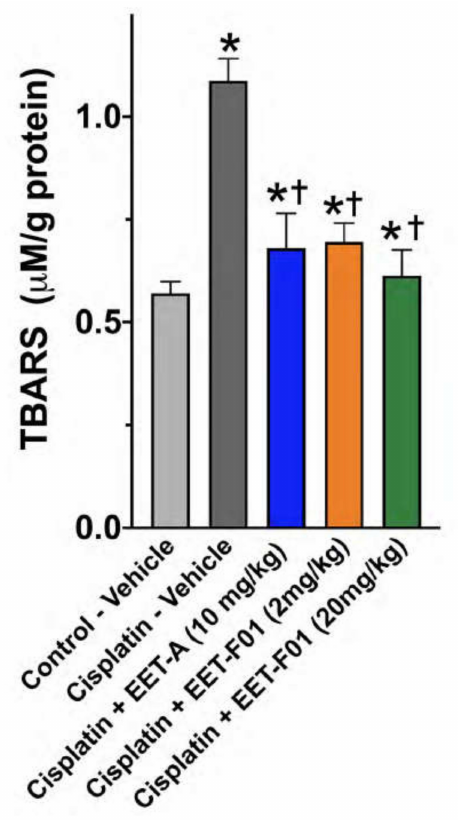
Figure 5. Kidney thiobarbituric acid reactive substances (TBARS) in cisplatin nephrotoxicity is reduced by EET-F01 and EET-A treatments. * p < 0.05 vs. control–vehicle group; † p < 0.05 vs. cisplatin–vehicle group. Data expressed as mean ± SEM, n =